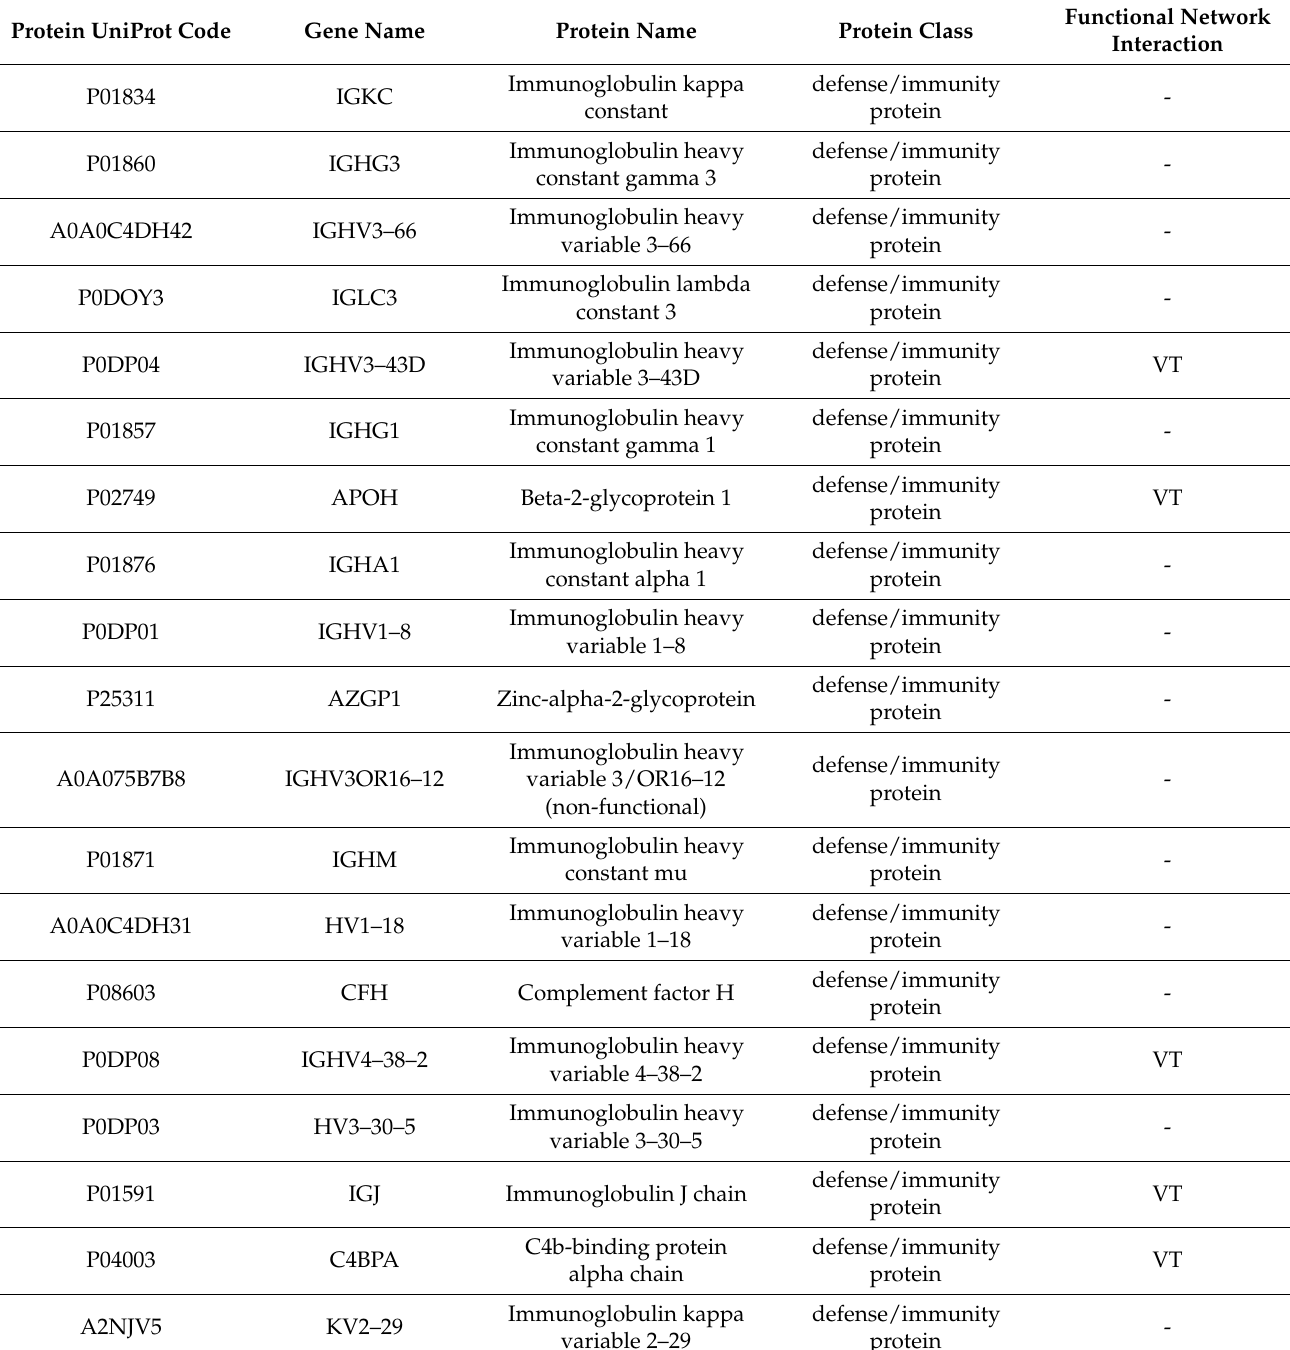
Table 1. The represented list has been obtained by identifying the proteins displayed by at least two PRP-EV isolated samples. The Uniprot code and the Gene name, Protein full name, Protein Classification, and Functional Network interaction are reported. WH means Wound Healing, VH means Vesicle-mediated